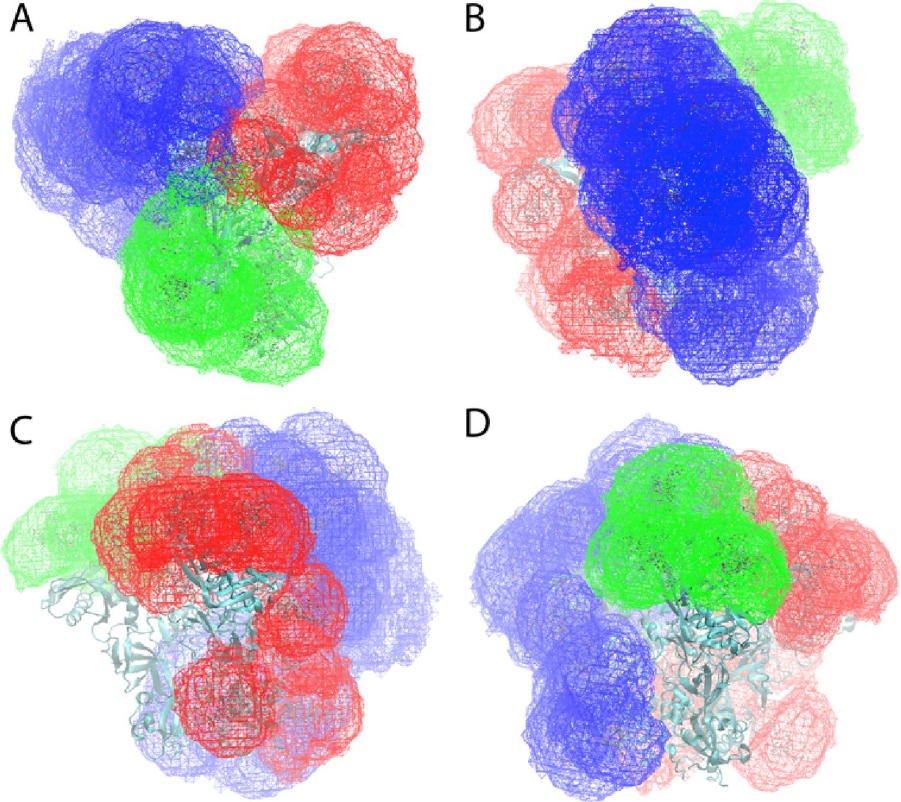
Figure 1. Cartesian volume representations of the range of sampling of all the glycans included in the ENV system. Glycans associated with M-1 are blue, with M-2 are red and with M-3 are green. Shown are ( A ) top view and side views towards ( B ) M-1, ( C ) M-2 and ( D ) M-3. Contour levels are 10 − 6 with the sum of the 1 Å 3 voxels normalized to 1. The protein is shown in cyan new cartoon representation generated with the program VMD 71